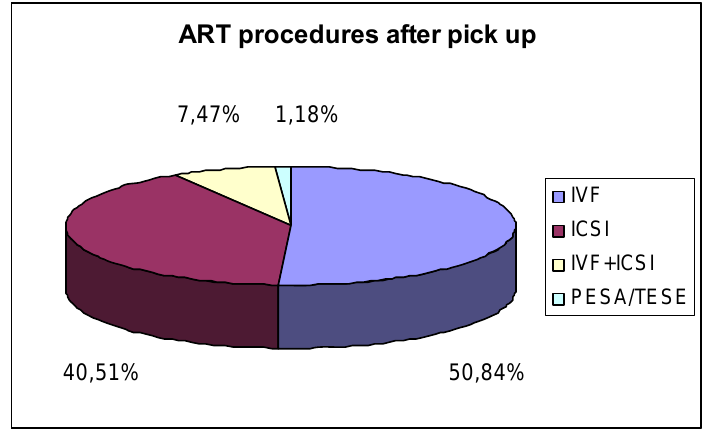
FIGURE 1 . Distribution of procedures, following oocyte retrieval.